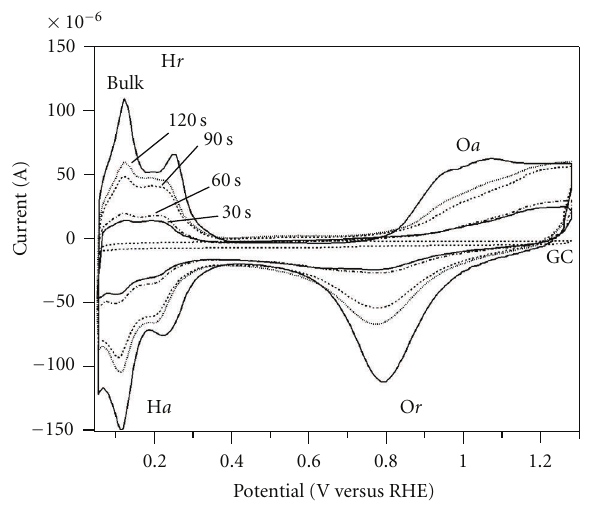
Figure 4: CVs of GC, ULPt(30s–120 s), and bulk Pt in 0.5 M sulfuric acid solution. The potential of the WE was scanned from 0.05 to 1.3V versus RHE with the sweep rate of 50 mV/s.